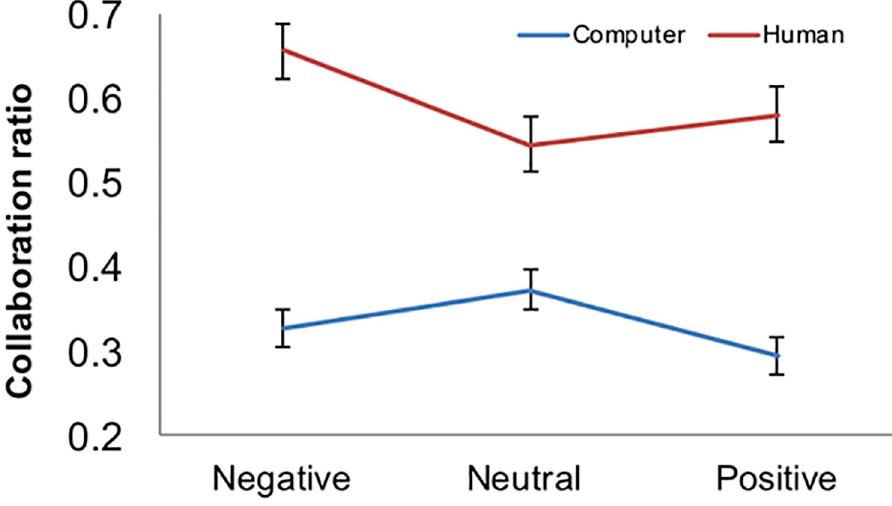
Fig 5. Cooperation with human and computer. Proportion of collaboration with human and computer partner across the three environmental contexts. Subjects collaborated more with human than computer partner and were overall less likely to cooperate in the positive environment (see main text). The error bars are standard